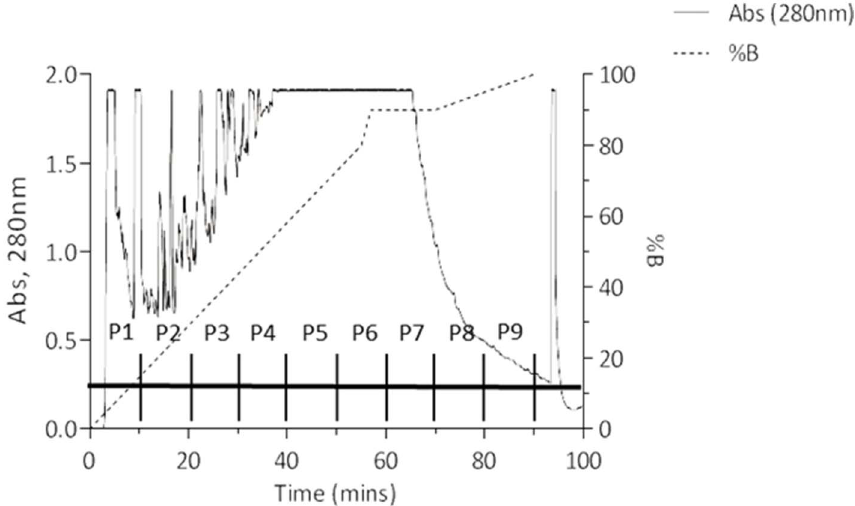
Figure 4. HPLC chromatogram and pools representation. Column: Waters Novapak C18 60A˚ 4 m m, 30 6 0.39 cm. Flow rate=1 ml/min. Buffer A: 2% CH3COOH. Buffer B: 2% CH3COOH, 25% CH3CN. Arrow indicates column strip with 2% CH3COOH, 75% CH3CN. Sample volume loaded=1 ml. Fractions collected at 1 min intervals. Pools compound of 10 individual fractions; P1:1–10, P2:11–20, P3:21–30. P4:31–40, P5:41–50, P6:51–60, P7:61– 70, P8:71–80, P9:81–90 and P10:91–100.